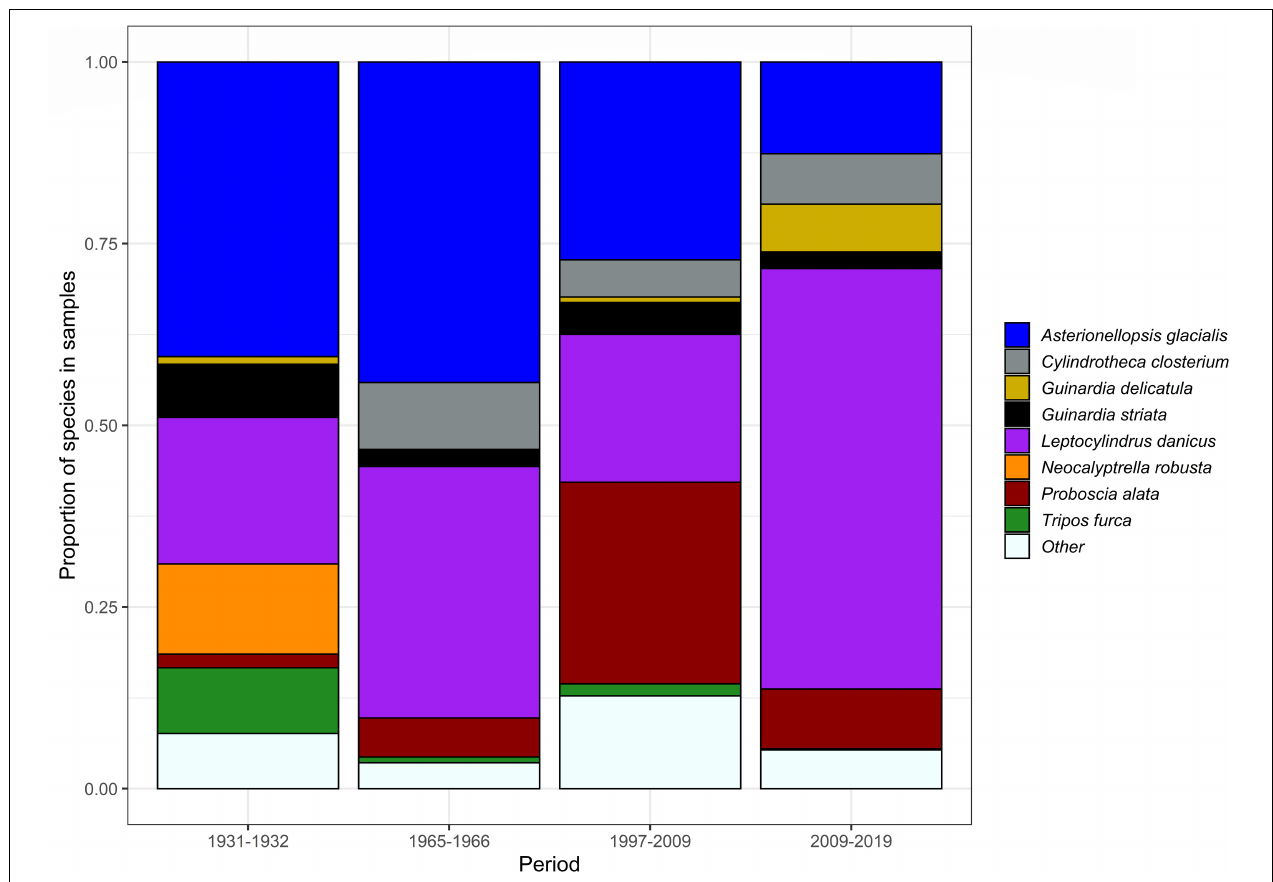
FIGURE 5 | Relative proportion of the dominant phytoplankton species from each sampling survey at PH 100m and their relative shifts in abundance from 1930 to